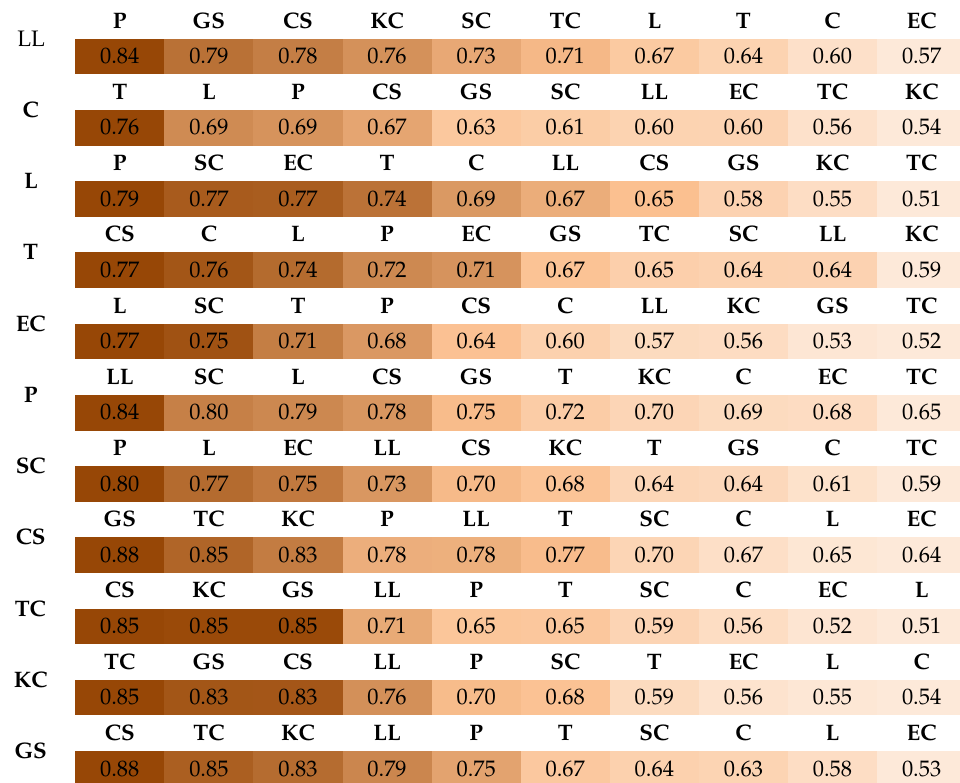
Table 11. Spectral visualization of the similarity of each PEO with the other